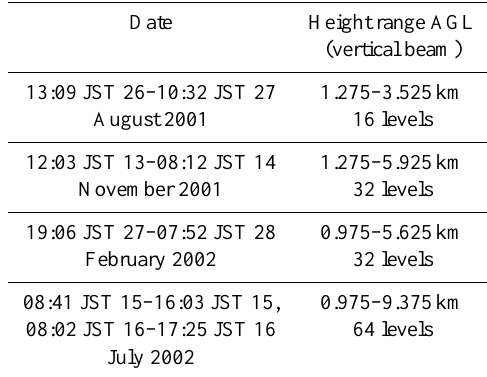
Table 1. List of case